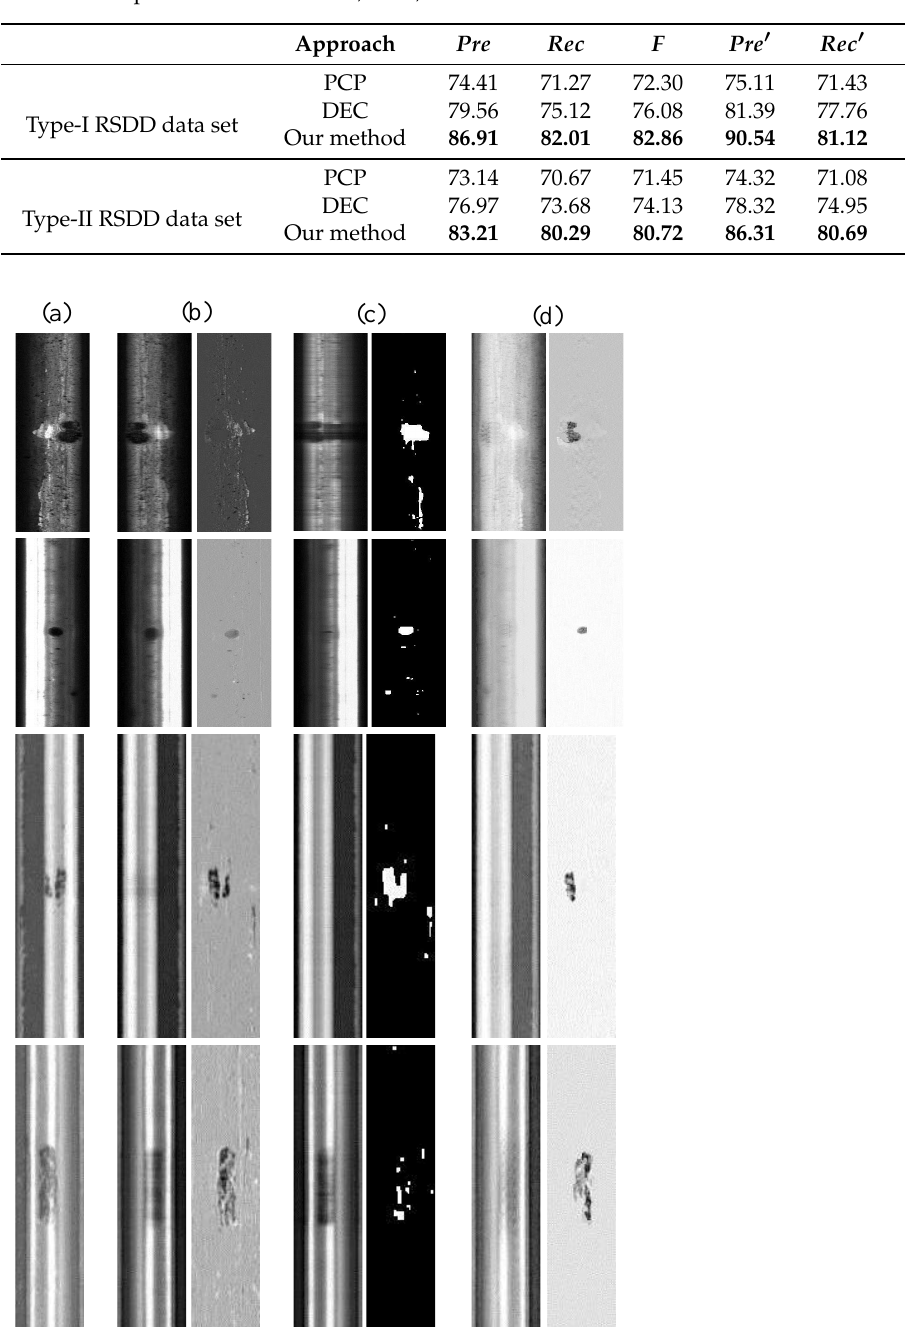
Table 4. Comparative results of PCP, DEC, and our method.